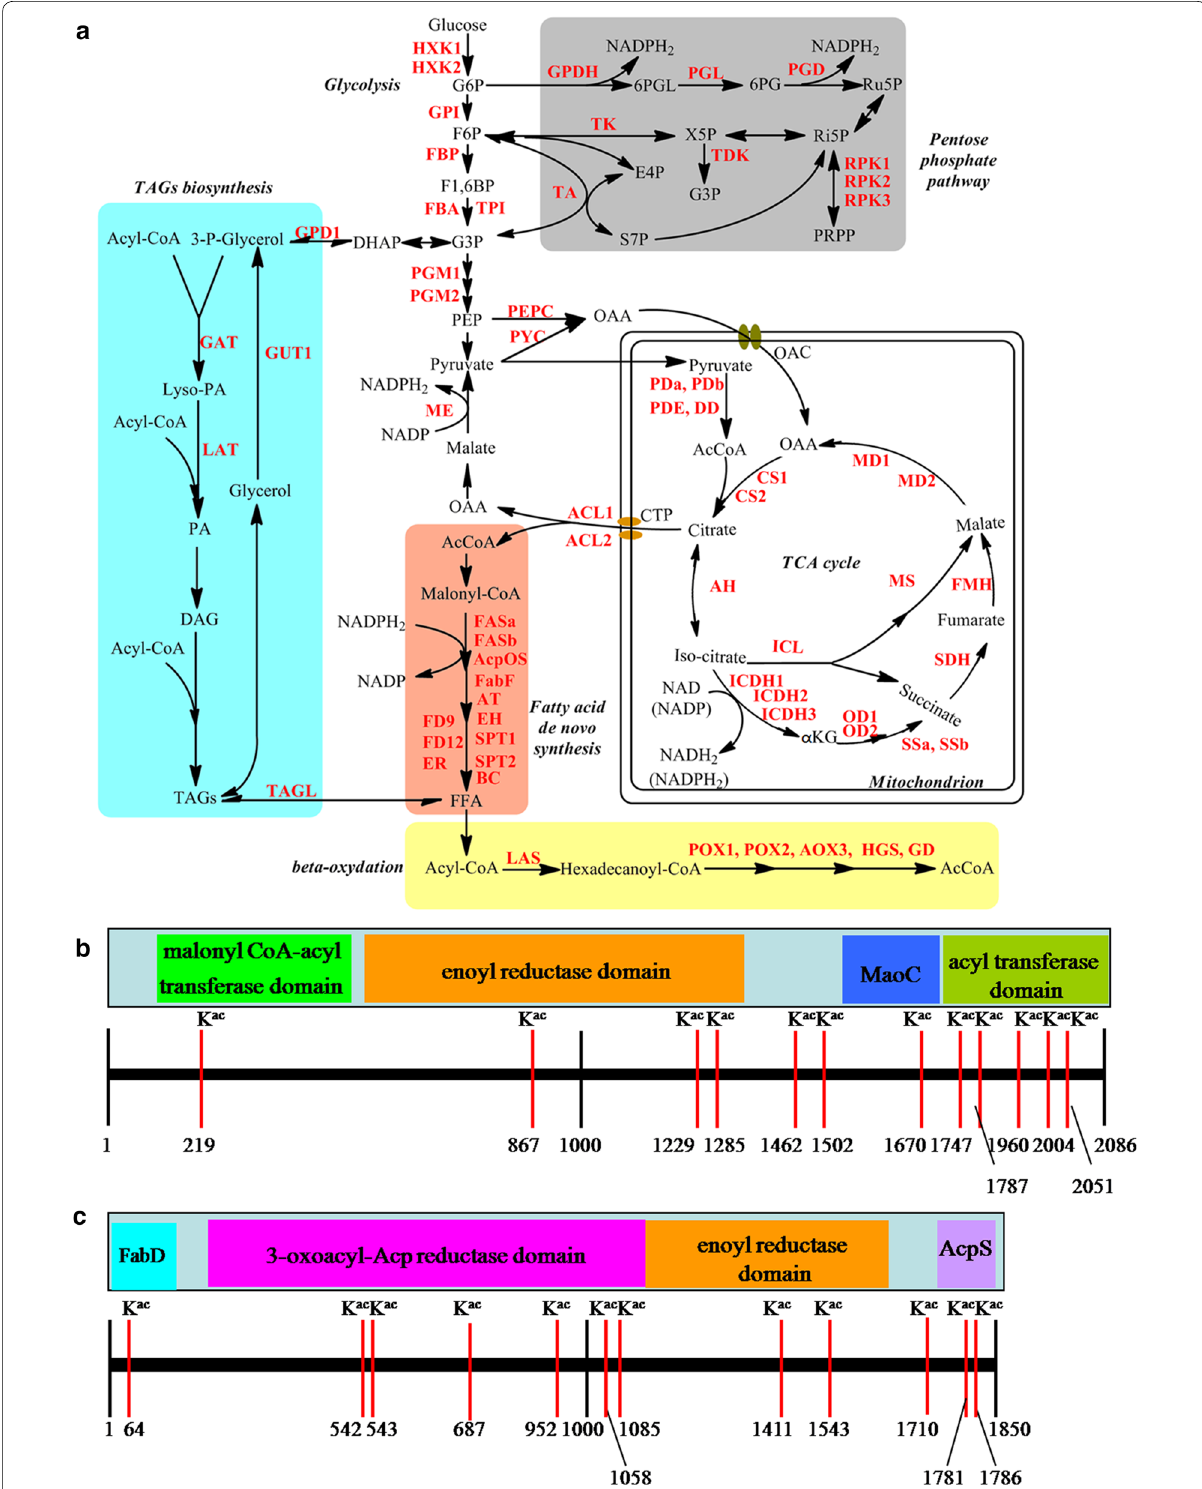
Fig. 8 Working scheme of lysine acetylated enzymes involved in central and triacylglycerols (TAGs) metabolism pathways in oleaginous yeasts. a Reconstruction of central and TAGs metabolism scheme from the KEGG pathway. Identified acetylated enzymes were highlighted in red . Abbrevia- tions for the components, enzyme symbols and annotations are included in Additional file 8: Tables S7. b An overview of acetylation sites in fatty acid synthetase (FAS1). c An overview of acetylation sites in fatty acid synthetase